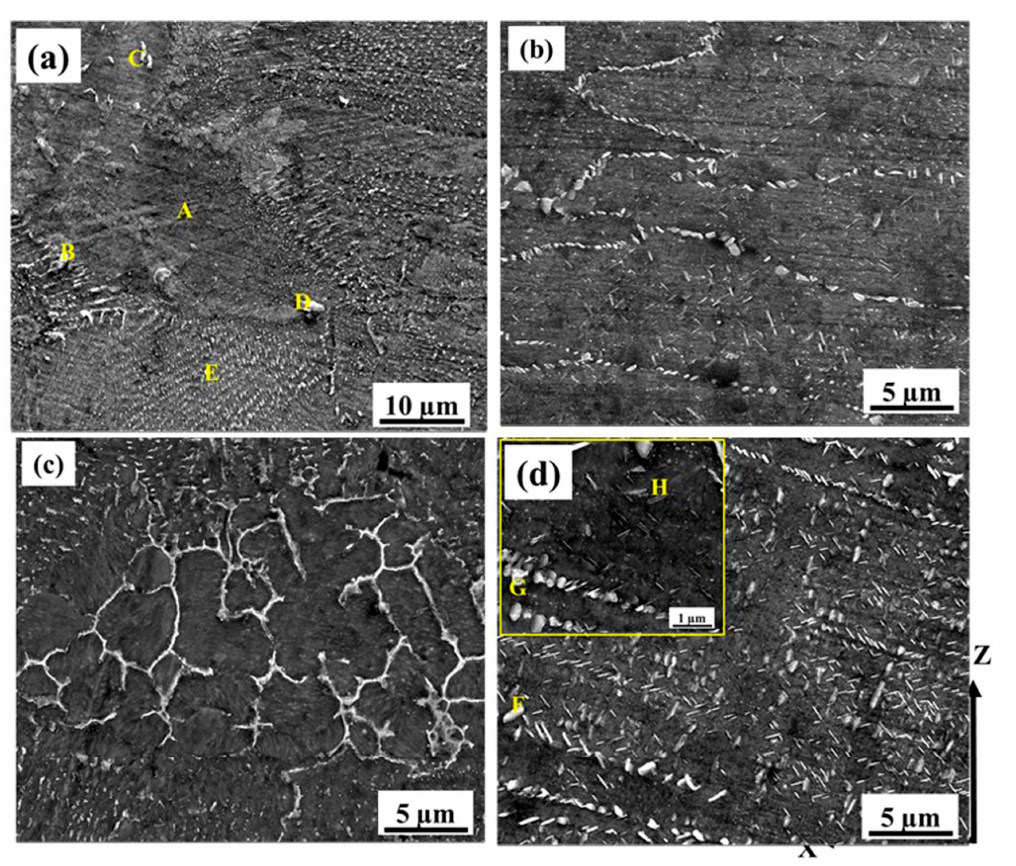
Figure 4. SEM microstructure of the XZ plane of ( a ) AB, ( b ) HT, ( c ) SP, and ( d ) HTSP samples. 230